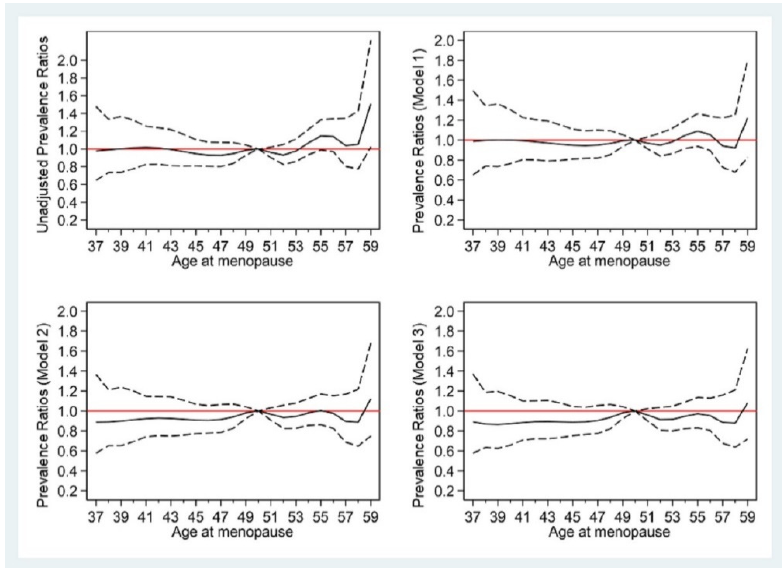
Figure 1. Prevalence ratios (solid line) and 95% confidence intervals (dashed lines) of age at menopause for type 2 diabetes mellitus (T2DM) (reference: 50 years old). Model 1: age; Model 2: age, BMI, parental history of T2DM, age at menarche, pregnancies, marital status; Model 3: age, BMI, parental history of T2DM, age at menarche, pregnancies, marital status, education, smoking, alcohol, exercise, hypertension, hyperlipidemia.